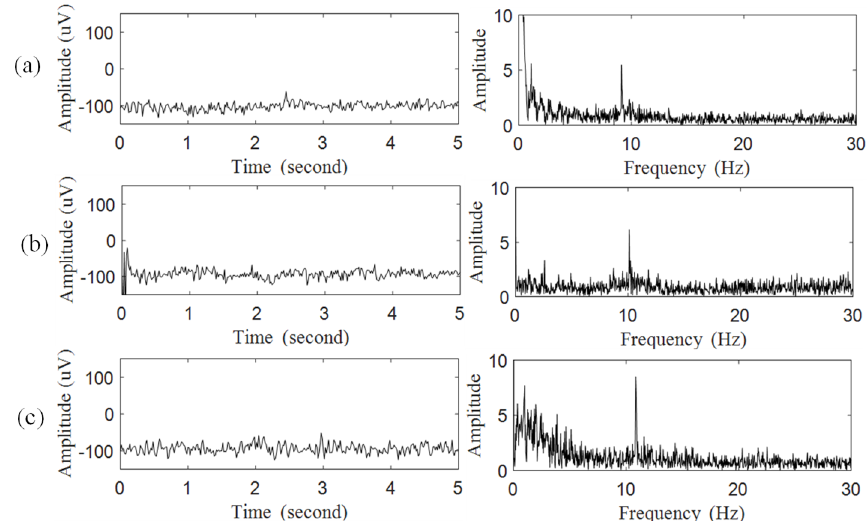
Figure 8. Raw SSVEP and their spectrum obtained by proposed BCI system when focusing on flashing icon with specific frequencies of ( a ) 9 Hz, ( b ) 10 Hz, and ( c ) 11 Hz.